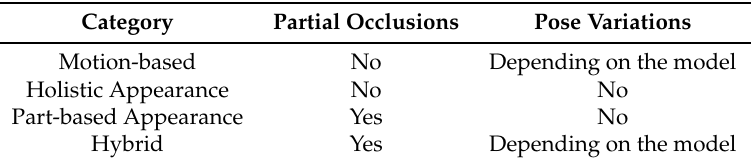
Table 3. People detection categories’ robustness